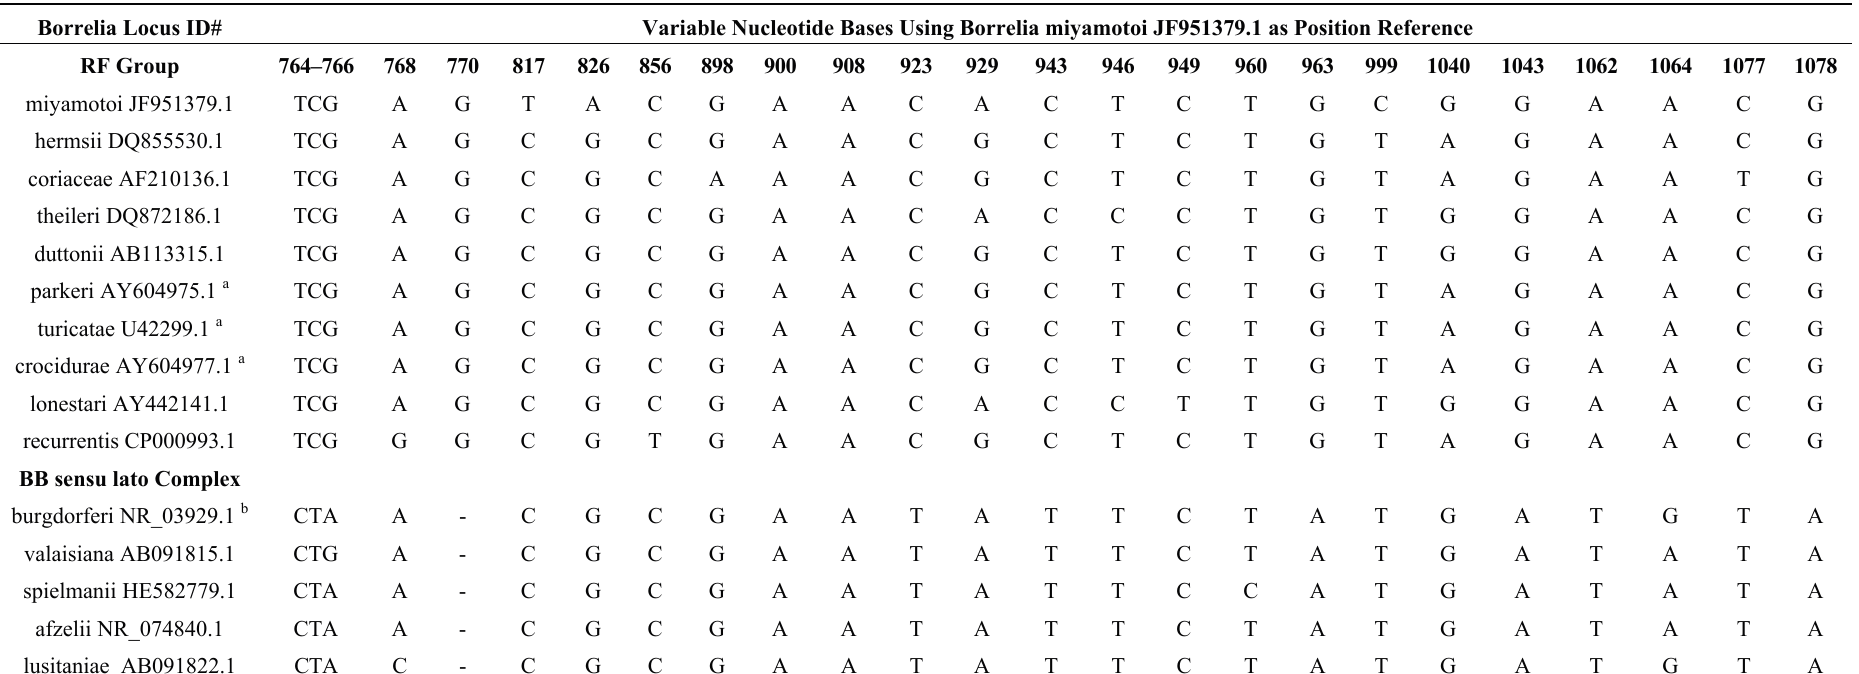
Table 1. Alignment of the hypervariable bases in a highly conserved borrelial 16S rDNA sequence. Borrelia Locus